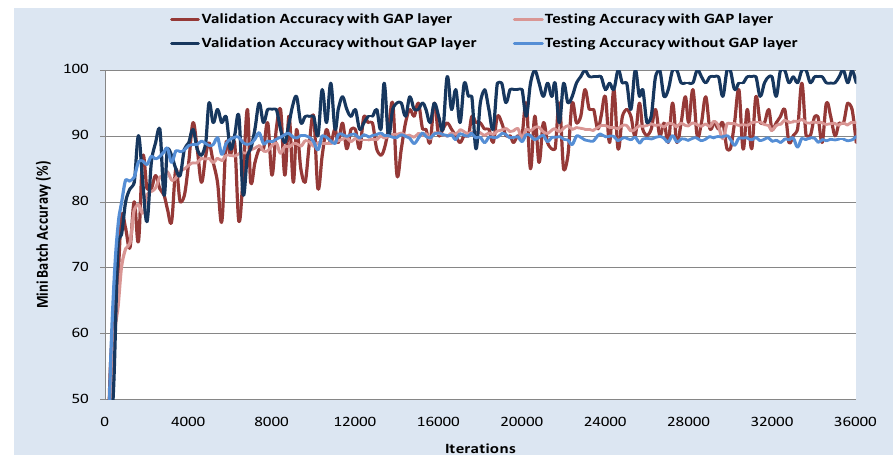
Figure 8. GAP layer effect on validation and testing accuracy.